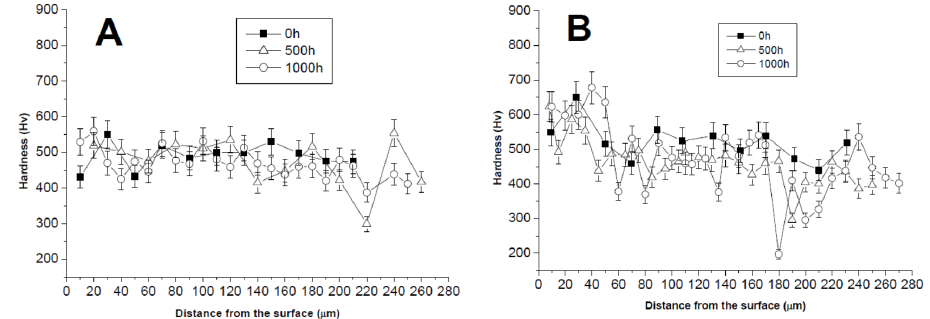
Figure 12. Compositional profiles of Al (full symbols) and Ni (empty symbols) for the cross sections depicted in Figure 10 as determined by EDS measurement. ( A ) and ( B ) panels depict data for IN738 + CoNiCrAlY + IL aluminizing + heat treatment and IN738 CoNiCrAlY + Pack aluminizing + heat treatment, respectively.